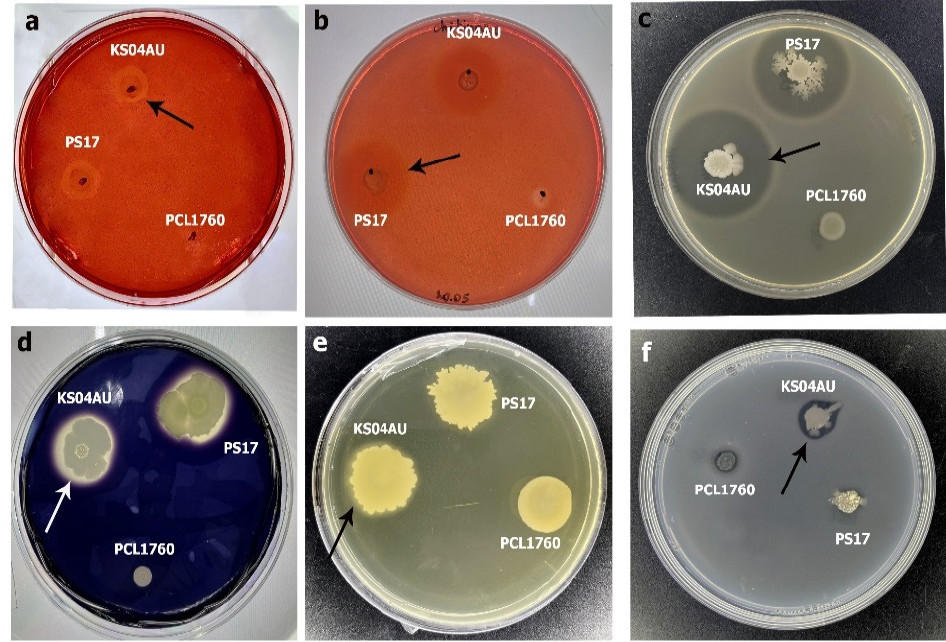
Figure 10. Hydrolytic enzymatic activity of B. velezensis KS04AU with arrows indicating enzymatic zone of activity. Plates showing cellulase ( a ), chitinase ( b ), protease ( c ), amylase ( d ), lipase ( e ), and phytase ( f ).